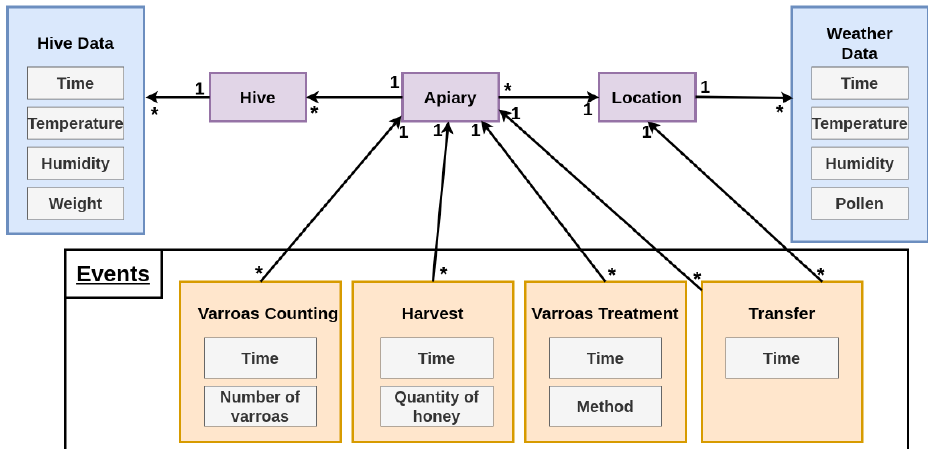
Figure 8. Excerpt from the central data model.